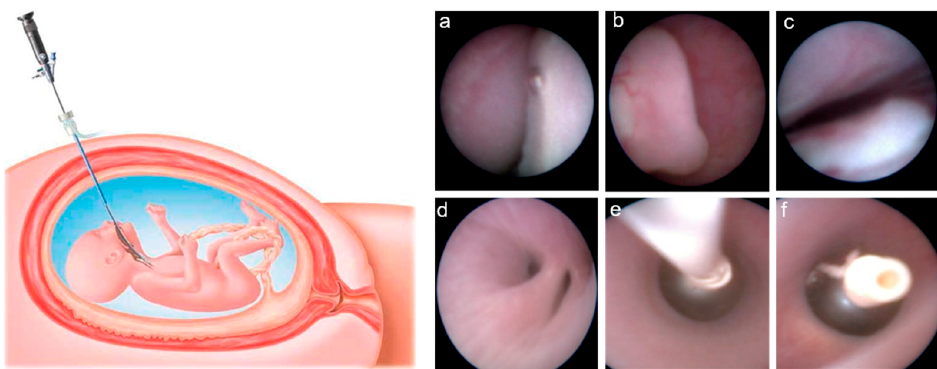
Figure 1. On the left side of the figure, schematic drawing showing intrauterine access to the fetal trachea by maternal percutaneous insertion of a fetoscope (reproduced from: Deprest, J.; Gratacos, E.; Nicolaides, K.H. Fetoscopic tracheal occlusion (FETO) for severe congenital diaphragmatic hernia: Evolution of a technique and preliminary results. Ultrasound Obstet. Gynecol. 2004 , 24 , 121–126 [11]). On the right side, endoscopic images showing the fetal oral cavity ( a ), the epiglottis ( b ), and the vocal cords ( c ), through which the fetoscope is advanced to reach the carina above the main bronchial bifurcation ( d ). At this level, the balloon is released through a catheter ( e ), inflated and detached to obtain tracheal occlusion ( f ).